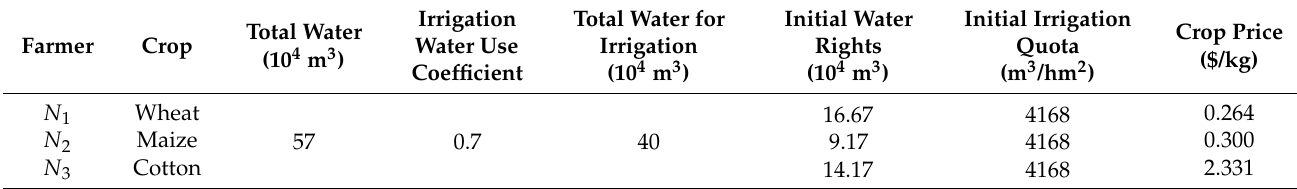
Table 1. Total irrigation water for crops and the initial water rights.